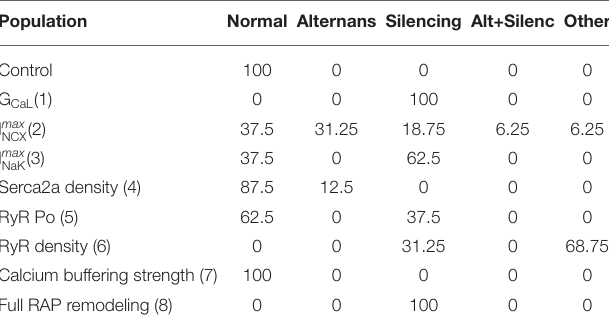
TABLE 3 | Effects of individually changing the RAP parameters in each of the 16 models of the control population. Population Normal Alternans Silencing Alt+Silenc